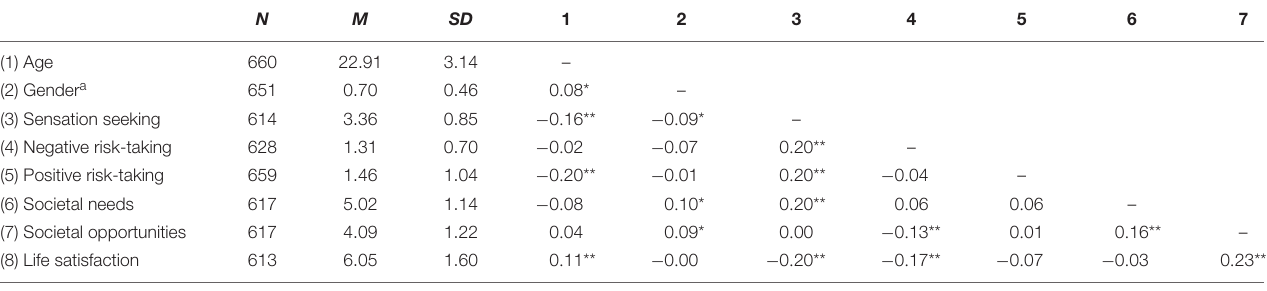
TABLE 1 | Number of participants, descriptive statistics, and correlations among study variables.